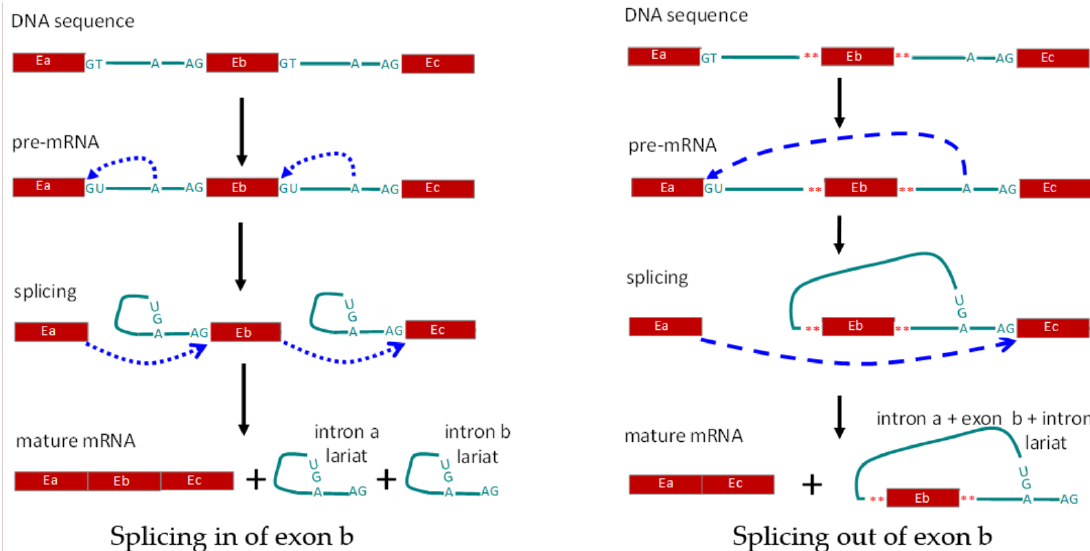
Figure 2. Schematic diagram showing regulation of alternative splicing in cis . Left panel, splicing in of exon b (Eb). Right panel, alternative splicing leading to removal of exon b. E: exon; A: branch site for RNA splicing; **: mutated